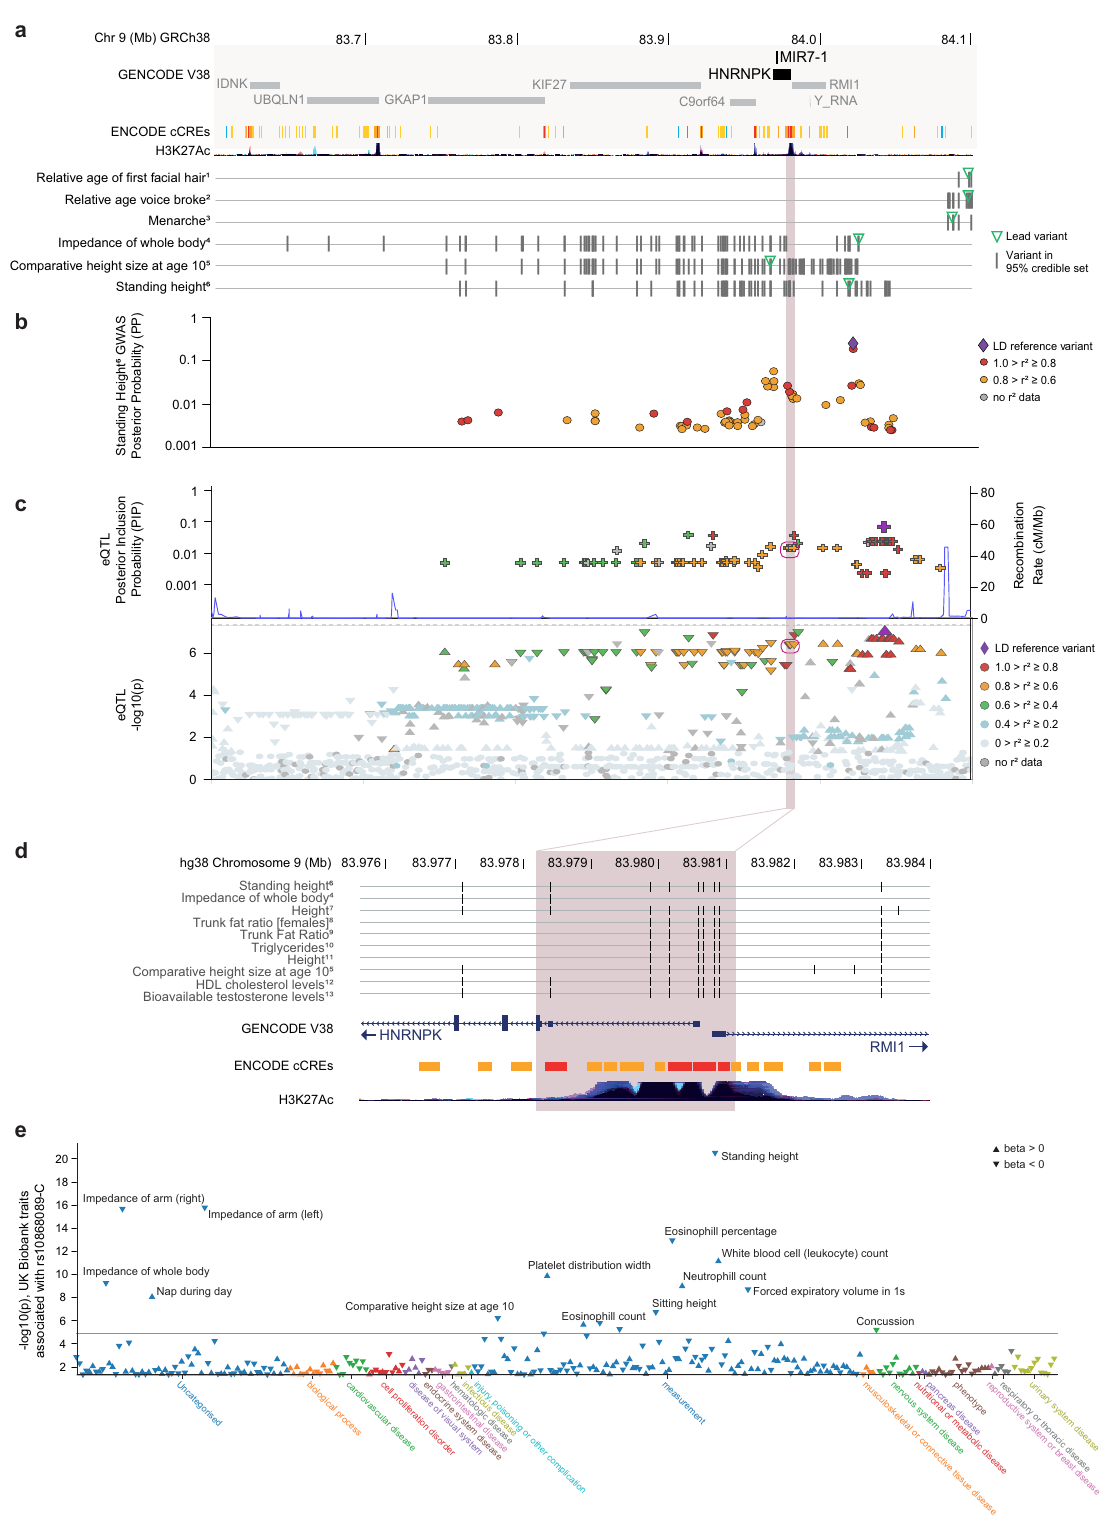
Sim1-cre;miR-7 fl / fl mice may contribute to phenotypes related to OXT and AVP release, such as water intake. weidenti fi ed Igsf8 and Snca asdirectmiR-7targetsthatareindividually suf fi cient to regulate energy homeostasis and neuroendocrine